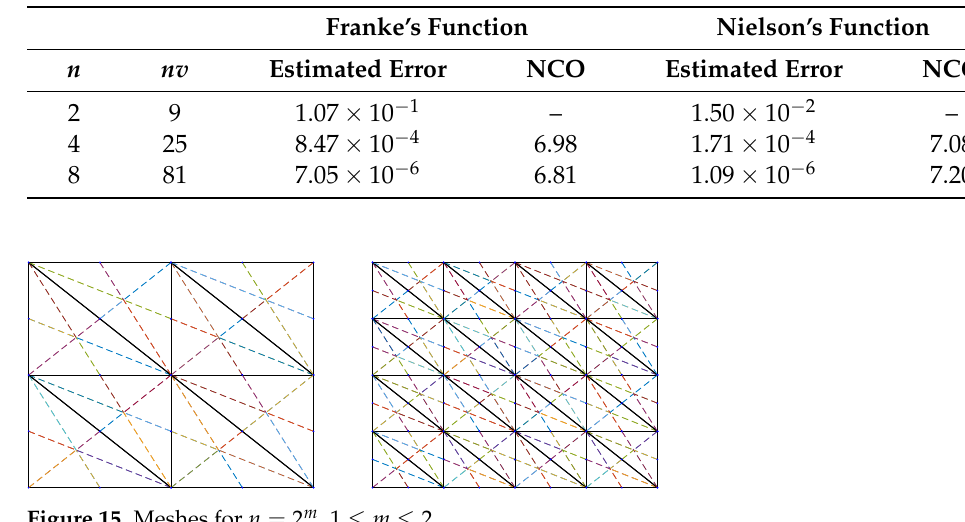
Table 1. Estimated errors for Franke and Nielson’s functions and NCOs with n = 2 m , 1 ≤ m ≤ 3.